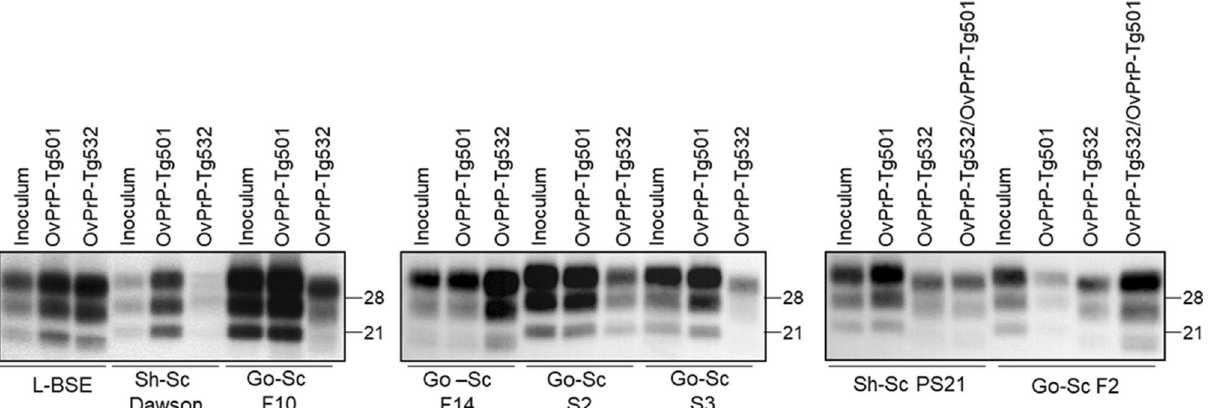
Figure 2. Comparison between inocula and brain PrP res in OvPrP-Tg501 and OvPrP-Tg532 mice. Immunoblotting of PrP res detected using Sha31 mAb. The figure illustrates a representative set of three independent experiments. Relative molecular mass in kDa at the left side. Full-length blots/gels are presented in Supplementary Figure